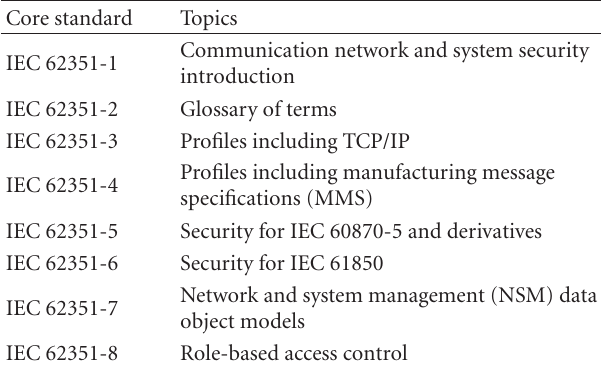
Table 3: IEC 62351 core